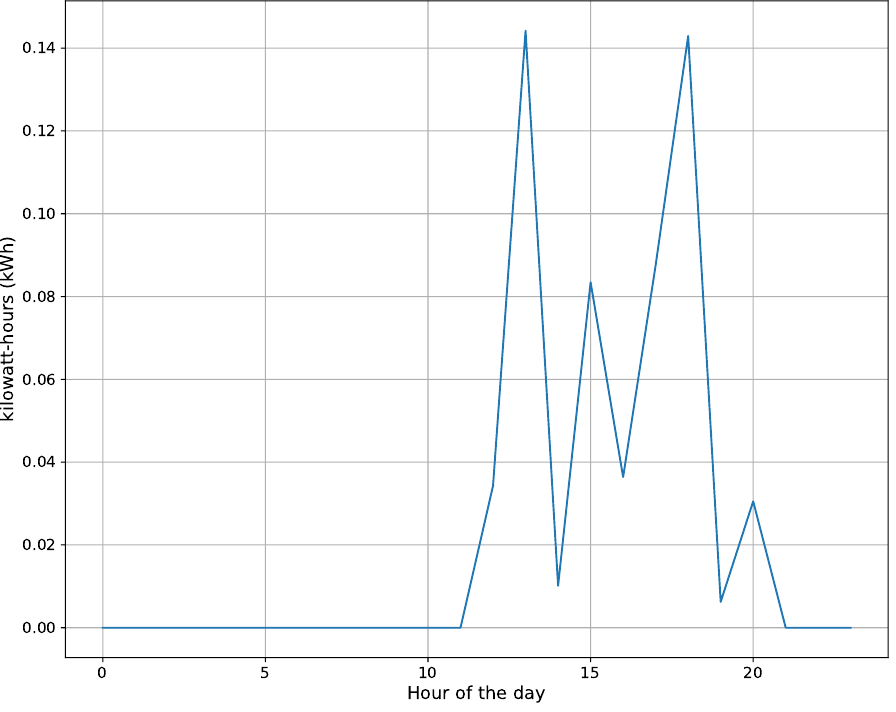
Figure 9. Energy consumption (in kWh) for TV site at house 3 on 6 June